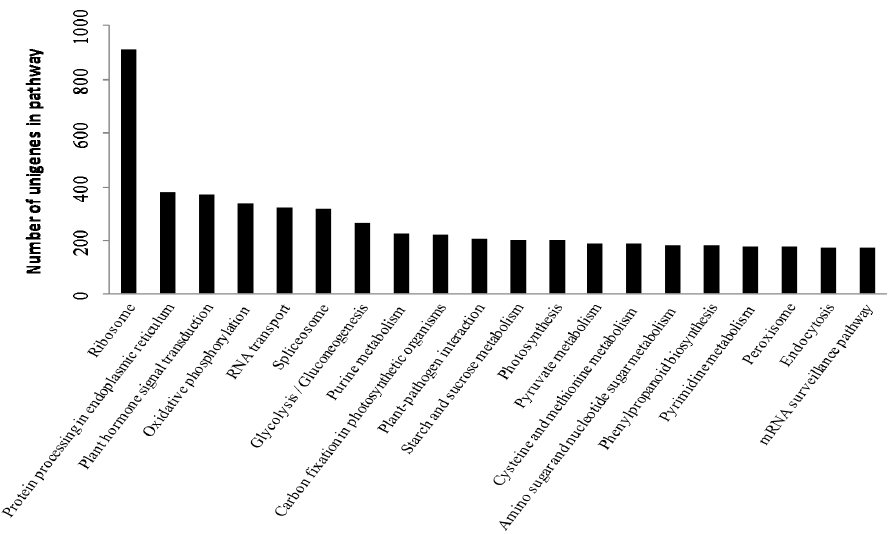
Figure 5. Kyoto Encyclopedia of Genes and Genomes (KEGG) classification of unigenes. 5,443 unigenes were assigned to the top 20 pathways in KEGG. Table 3. List of triterpene saponin biosynthesis-related genes in the Gynostemma transcriptome. Gene